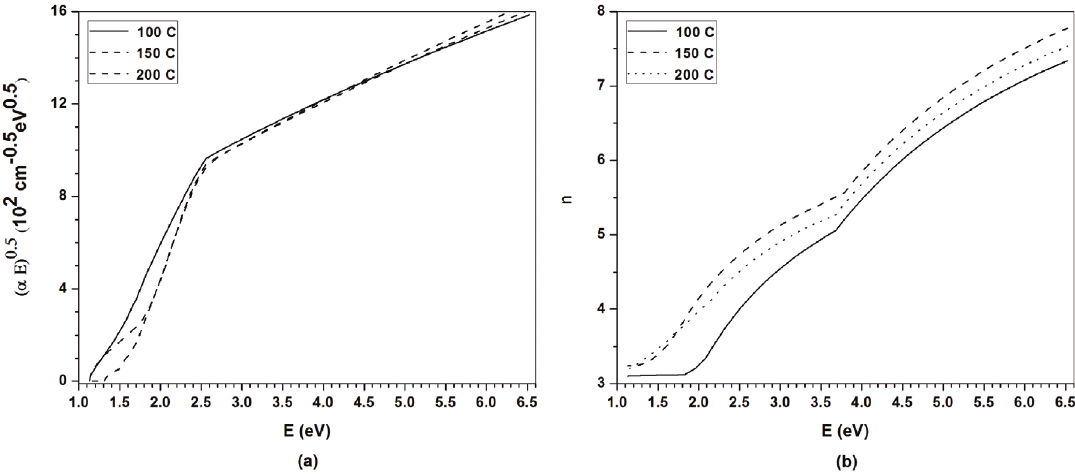
Figure 6. The plot of Tauc- Pankove relation (a) and dispersion of refractive index (b). (The related data are extracted from measured absorption coefficient, transmittance and